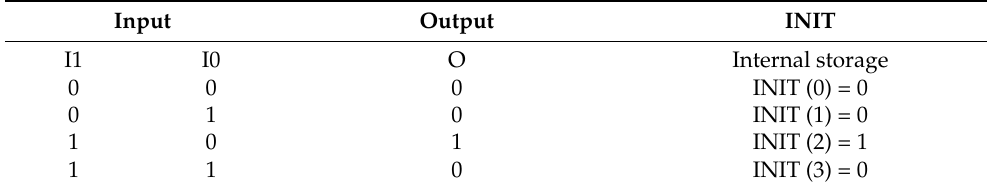
Figure 7. Schematic diagram of a ring oscillator constructed by a look-up table.